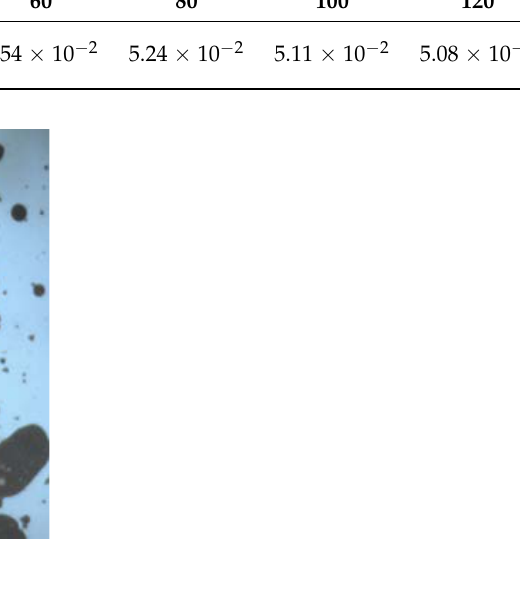
Table 5. Relationship between polymer microsphere particle size and hydration time.